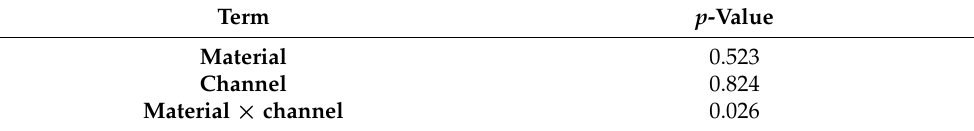
Table 3. Test of fixed effects in the mixed multilevel model using EDA as a response.